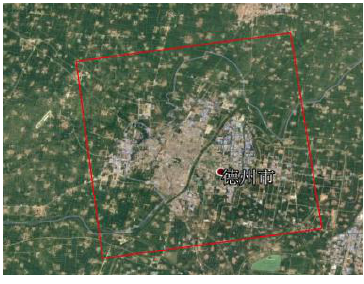
Figure 1. Scope of the experimental area